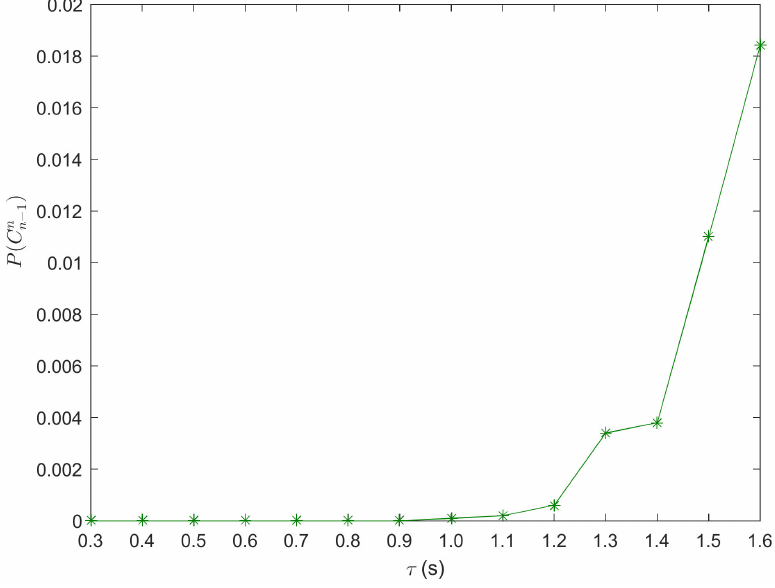
Figure 4. Varying of REC probability with response